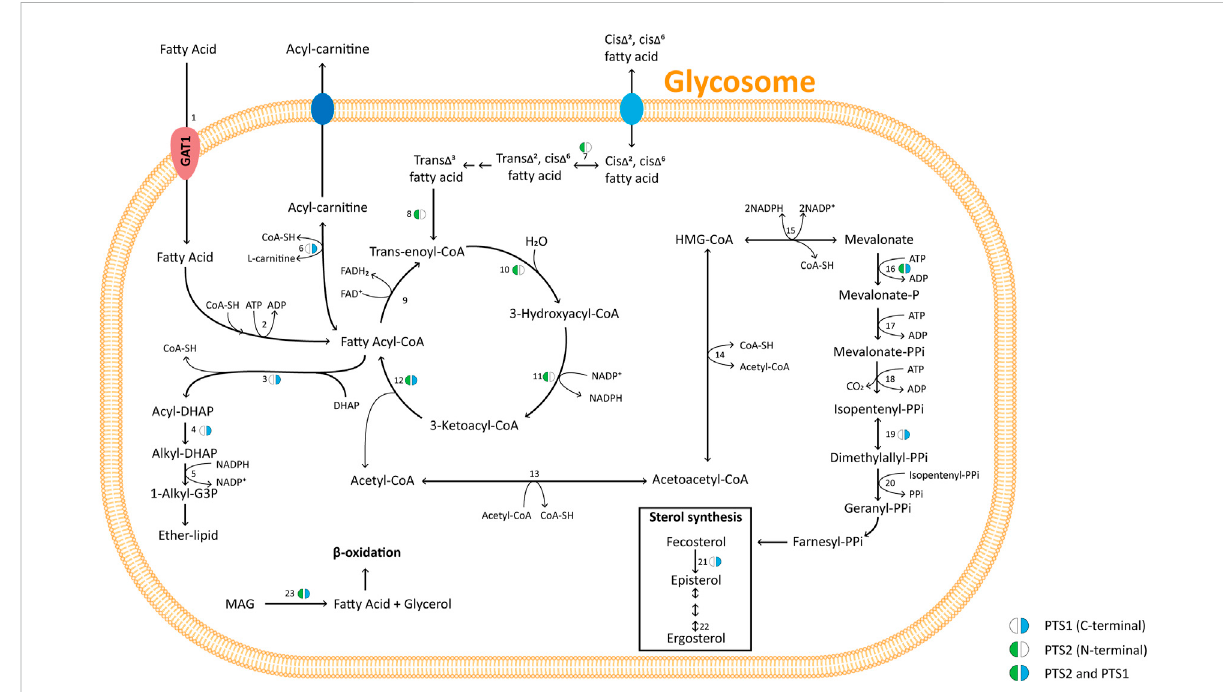
FIGURE 5 Pathways of glycosomal lipid metabolism in TriTryps species. Pathways of ether-lipid synthesis (enzymes 3 – 5), fatty-acid β -oxidation (9 – 12), andsterolsynthesis (16 – 23)are represented. Notethat notall enzymesindicatedarepresentineachoftheTriTrypsspecies orexpressedineachof their life-cycle stages, and for simplicity not all reactions are represented. Enzymes/transporter: 1. Glycosomal ABC transporter (GAT1); 2. Fatty-acyl CoA synthetase; 3 . DHAP acyltransferase; 4 . Alkyl-dihydroxyacetone phosphate synthase; 5 : 1-Alkyl G3P:NADP + oxidoreductase; 6 . Carnitine O-palmitoyltransferase; 7. 3,2-Trans-enoyl-CoAisomerase; 8. Enoyl-CoAisomerase; 9 .Acyl-CoAdehydrogenase; 10,11,12. Enoyl-CoAhydratase/ 3-hydroxyacyl-CoA dehydrogenase/3-ketoacyl-CoA thiolase (trifunctional enzyme); 13 . Acetyl-CoA acetyltransferase 14 . 3-Hydroxy-3- methylglutaryl CoA synthase; 15 . 3-Hydroxy-3-methylglutaryl-CoA reductase; 16 . Mevalonate kinase; 17 . Phosphomevalonate kinase 18 . Mevalonate diphosphate decarboxylase 19. Isopentenyl-diphosphate δ -isomerase; 20 . Farnesyl diphosphate synthase 21 . C-8 sterol isomerase; 22 . Sterol C-24 reductase; 23. Monoacylglyceride lipase. MAG : monoacylglycerol. Enzymes 13, 14, 15, 17, 18 and 20 have been detected experimentally with a PTS motif in mammalian peroxisomes (references cited in Acosta et al.,